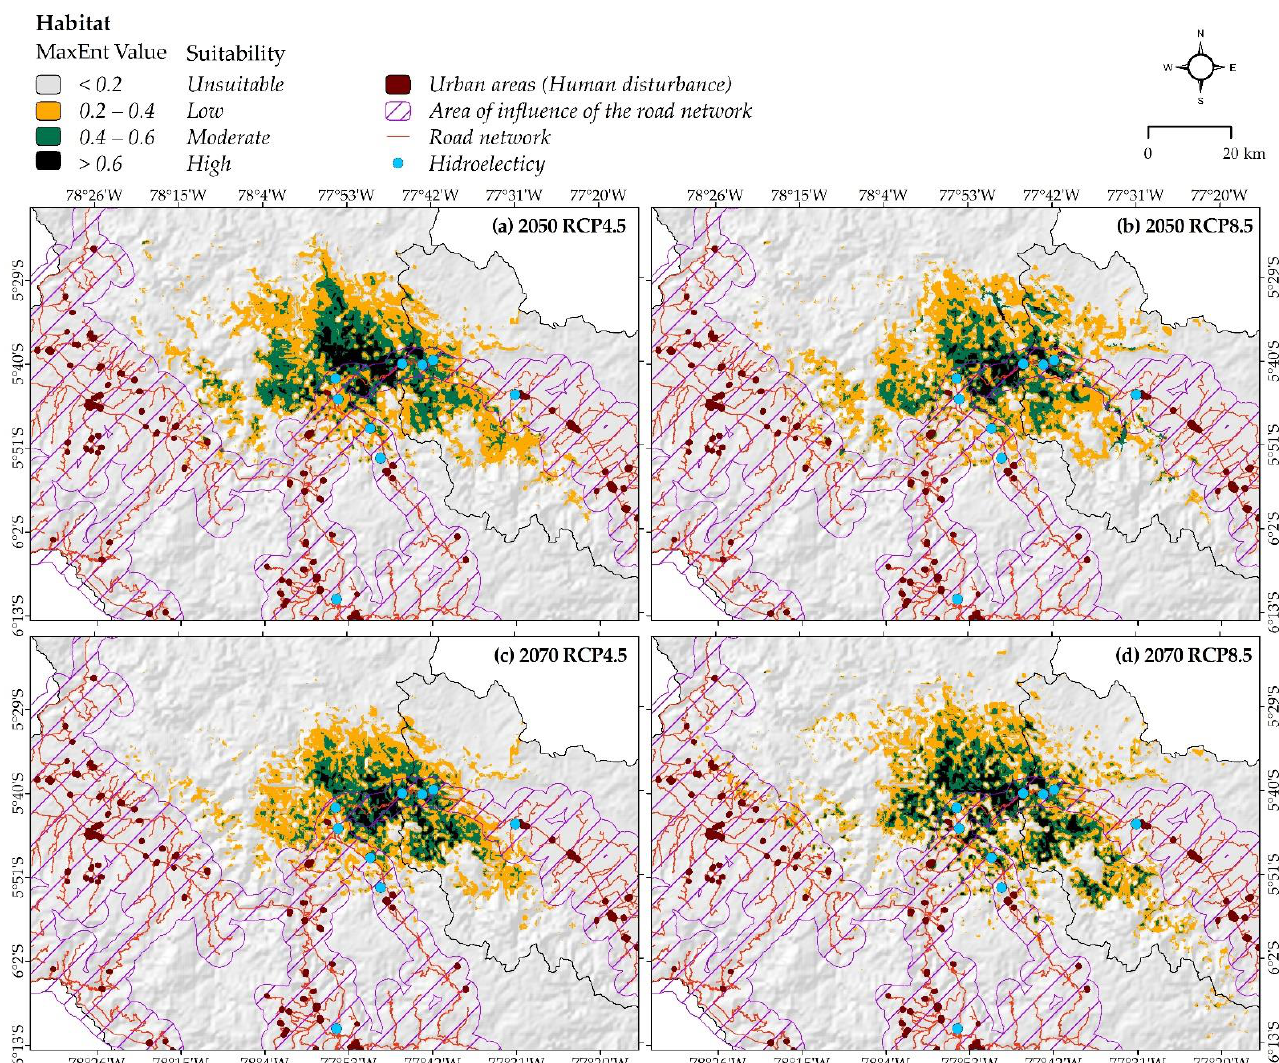
Figure 7. Overlapping human disturbance factors in future scenarios of X. loweryi in Amazonas and San Martin regions (Peru). Table 3. Changes in habitat suitability of X. loweryi in the study area considering human disturbance factors by 2050 and 2070.